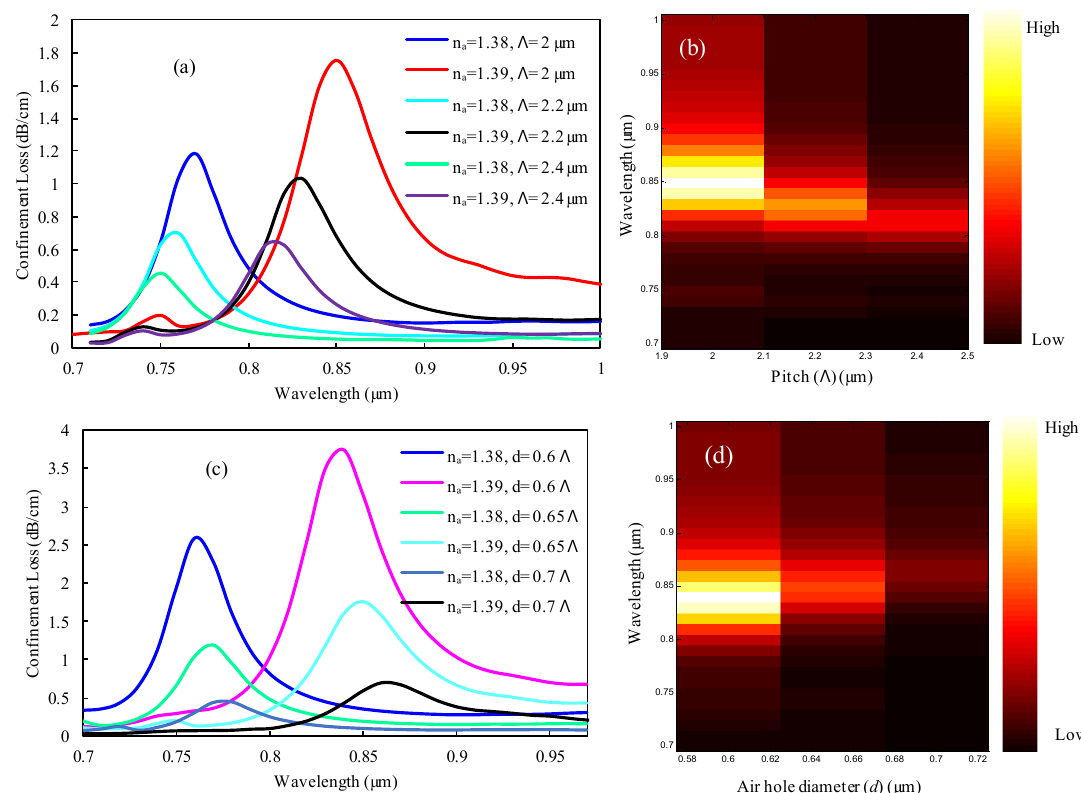
Figure 6. Representation of loss spectrum for ( a ) pitch ( Λ ) variation from 2 to 2.4 µ m, ( c ) air hole diameter, and ( d ) variation from 0.6 Λ to 0.7 Λ for n a values of 1.38 and 1.39; ( b ) and ( d ) represent the loss intensity for Λ and d variation for n a of 1.39. Table 2. Performance comparison with the previously reported PCF ‐ SPR sensor.